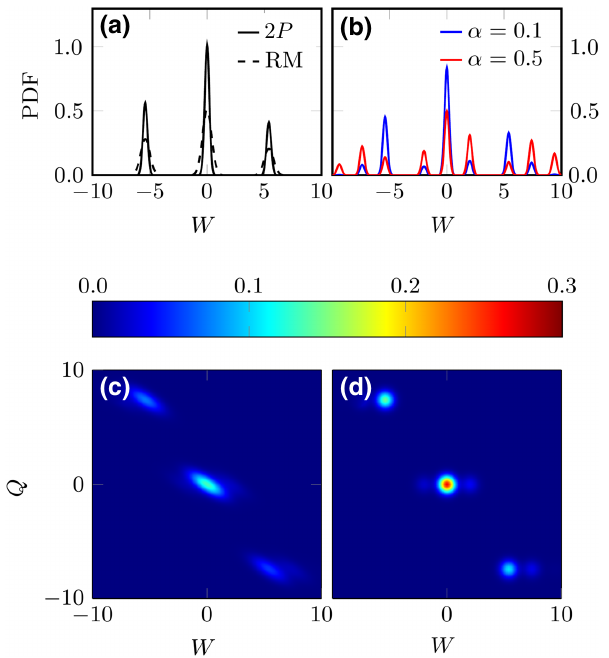
FIG. 3. (a),(b) The PDFs of work for adiabatic work strokes ( α = 0) and different measurement schemes (a) as well as for different nonadiabatic work strokes (b). Solid lines represent two-pointer repeated-contact PDFs, and the dashed line presents the PDF for repeated measurements. One-pointer results are not drawn since they are exactly the same as for the two-pointer scheme for α = 0 and have a negligible difference for α (cid:10)= 0. (c) The joint PDF of work and heat calculated for repeated measure- ments, and (d) the joint PDF calculated for two-pointer repeated contacts. The PDFs are computed for perfect thermalization with thermal baths at inverse temperatures β c = 0.25, β h = 0.025, both characterized by the the same Ohmic spectral density with Lorentz-Drude cutoff frequency ω D = 0.2, system operator S = σ z + σ x , and damping coefficient γ = 0.5. This results in density matrices with an excited-state probability d c = 0.37759 and d h = 0.45388, and coherence q u = (cid:4)+ u | ρ u |− u (cid:5) given by q h = − 1.9205 × 10 − 6 and q c = 5.0813 × 10 − 5 (see Appendix A for details). The phase during the nonadiabatic evolution is set to ϕ = 0 in all cases, and the joint PDF is shown for α = 0.1. The engine is started in the generalized Gibbs state of the cold bath with parameters d c and q c . All other parameters are the same as in Fig. 2.